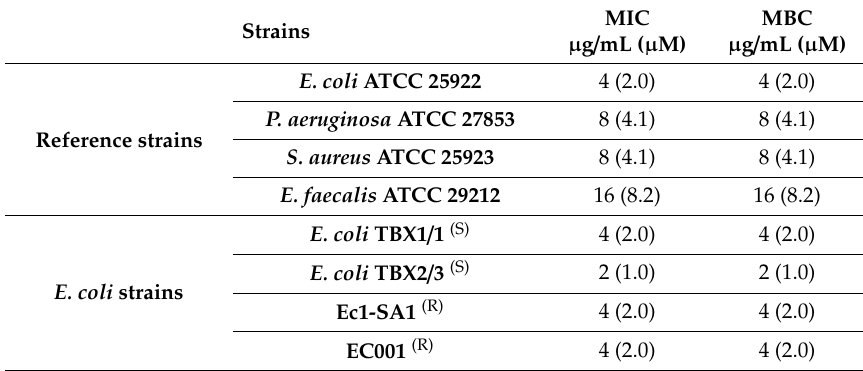
Table 1. Minimum inhibitory concentration (MIC) and minimum bactericidal concentration (MBC) values of peptide Hs02 against several susceptible and multidrug-resistant